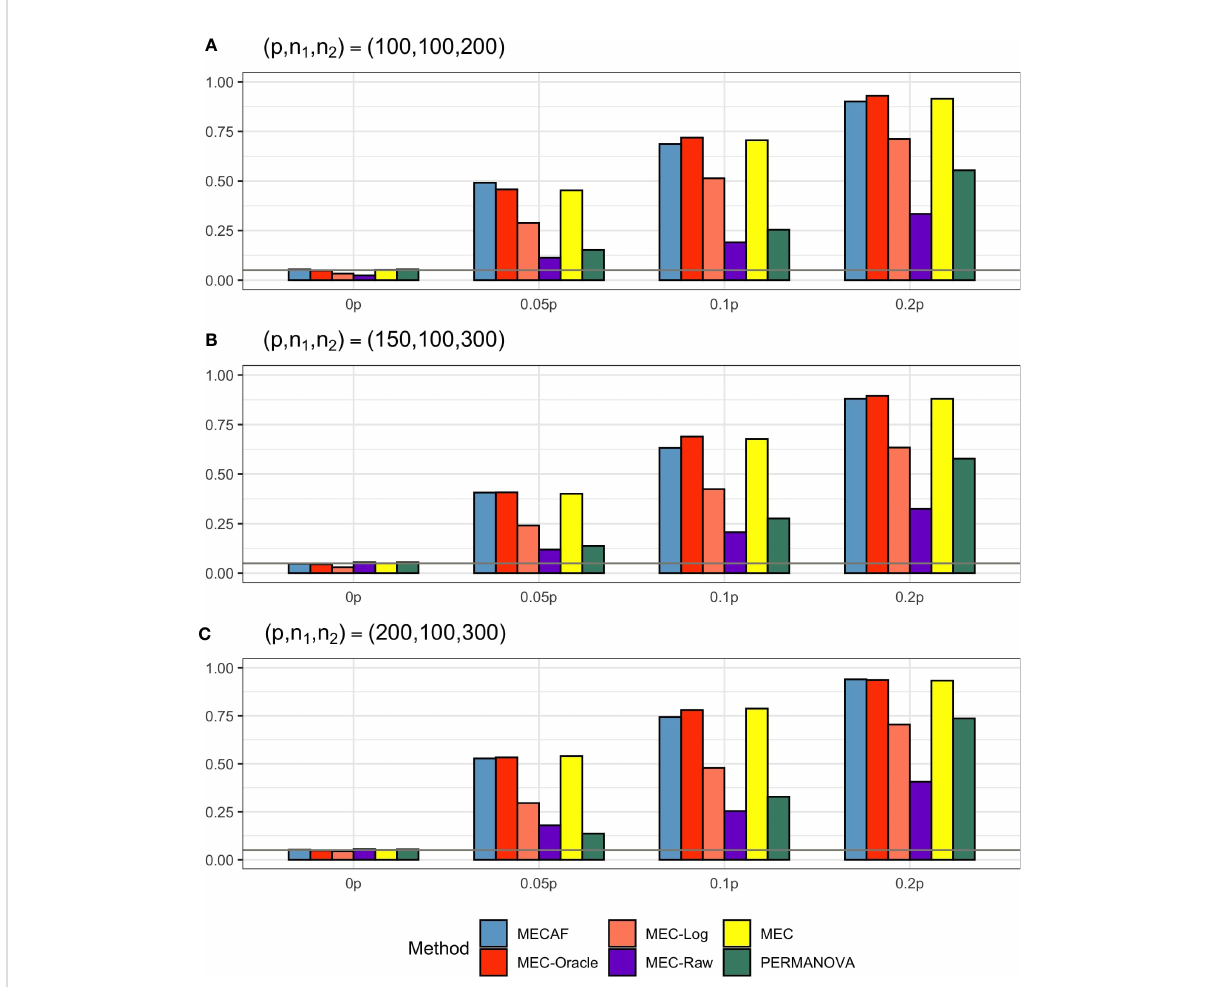
FIGURE 3 Simulation results for Scenario 3: same sparse covariance matrix between compared groups. The empirical type I error rate (H_0: 0p) and statistical power under three sparsity measures ( H a :0.05 p , 0.1 p , and 0.2 p ) for MECAF and competing methods MEC-Oracle, MEC-Log, MEC- Raw, and MEC. A horizontal line with a = 0.05 indicates the signi fi cance level. The number of taxa and sample sizes were set as follows: (A) ( p , n p , n n p , n n n 1 , 2 ) = (100,100,200); (B) ( 1 , 2 ) = (150,100,300); (C) ( 1 , 2 ) =